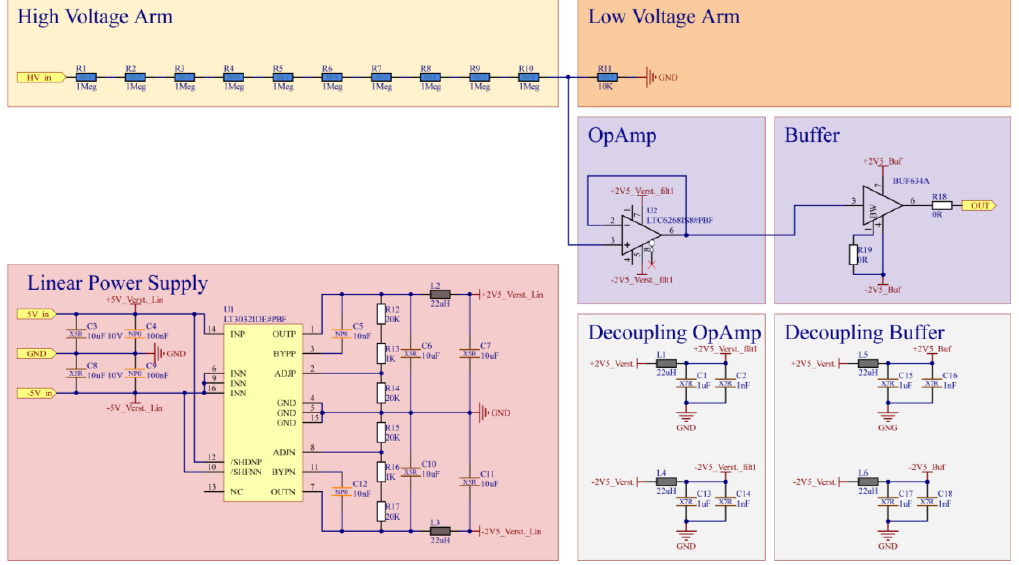
Figure A2. Schematic of the used electrical components of the resistive voltage divider. With HVA and LVA in orange, the buffer stage in purple, and the linear regulator for power supply in red with the respective decoupling elements.